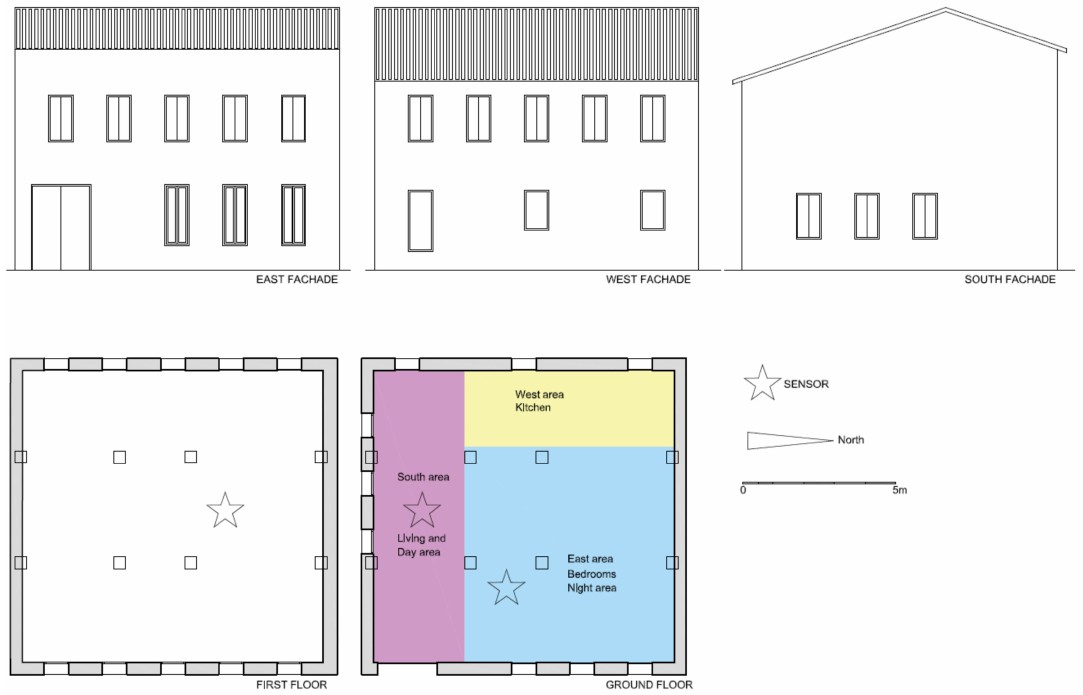
Figure 2. Base model for a house with three different areas: west (kitchen), south, and east (day and night use) for the ground floor, and under the roof for the first floor only with one